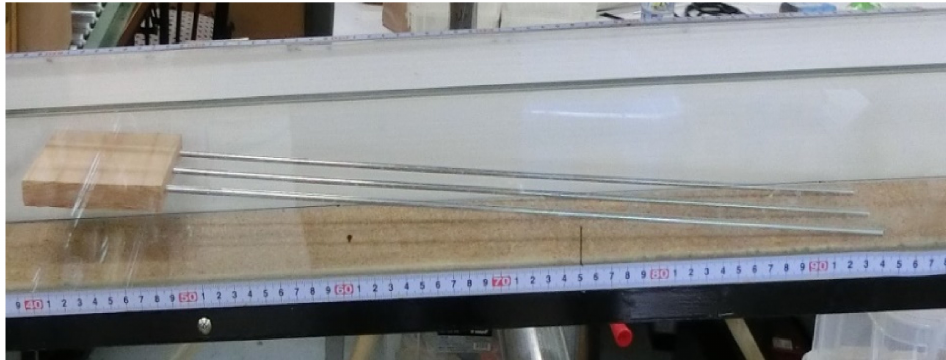
Figure 5. Installation of the LW trap in the flume (photograph shows a trap with three rods).